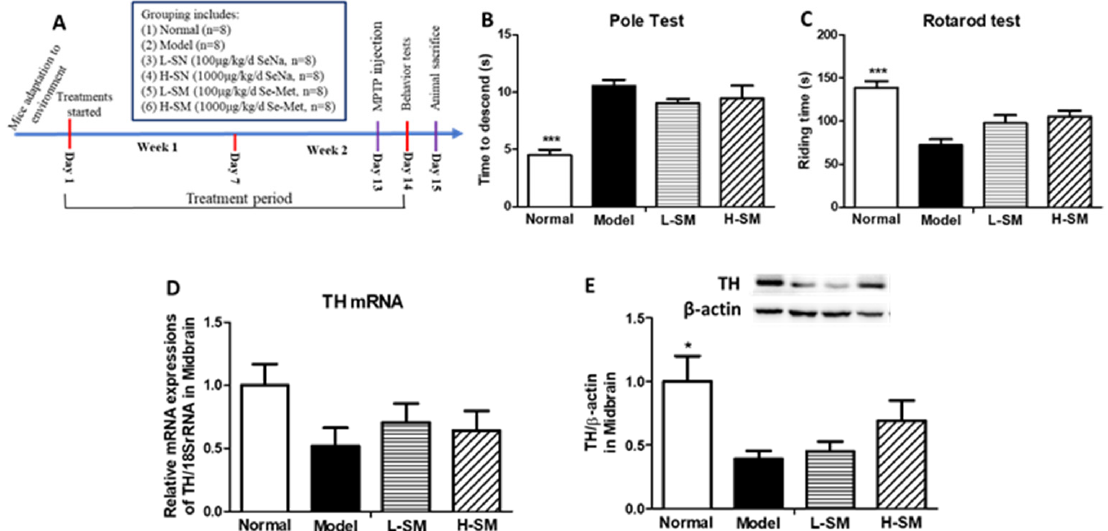
Figure 1. Comparative effects of Se ‐ Na and Se ‐ Met in acute PD mice model. ( A ) Timeline of animal experiments. ( B ) Pole test of mice indicated by total time to descent(s). ( C ) Rotarod test of mice indicated by riding time on the rod(s). TH gene ( D ) and protein ( E ) expressions in the midbrain of mice in each group. TH mRNA expressions were shown as a quantitative ratio of TH to 18S rRNA gene and relative to the group mean of the Normal group. For protein expressions, one representa ‐ tive band for TH and endogenous β‐ actin from each group; and the following bar chart shows the ratio of TH/ β‐ actin in each group in the midbrain of mice. Values are expressed as mean ± SEM, n = 6 ‐ 8. * p < 0.05, *** p < 0.001 vs. Model group. Se ‐ Na, sodium selenite; Se ‐ Met, Seleno ‐ L ‐ methionine; PD, Parkinson’s disease; TH, tyrosine hydroxylase.